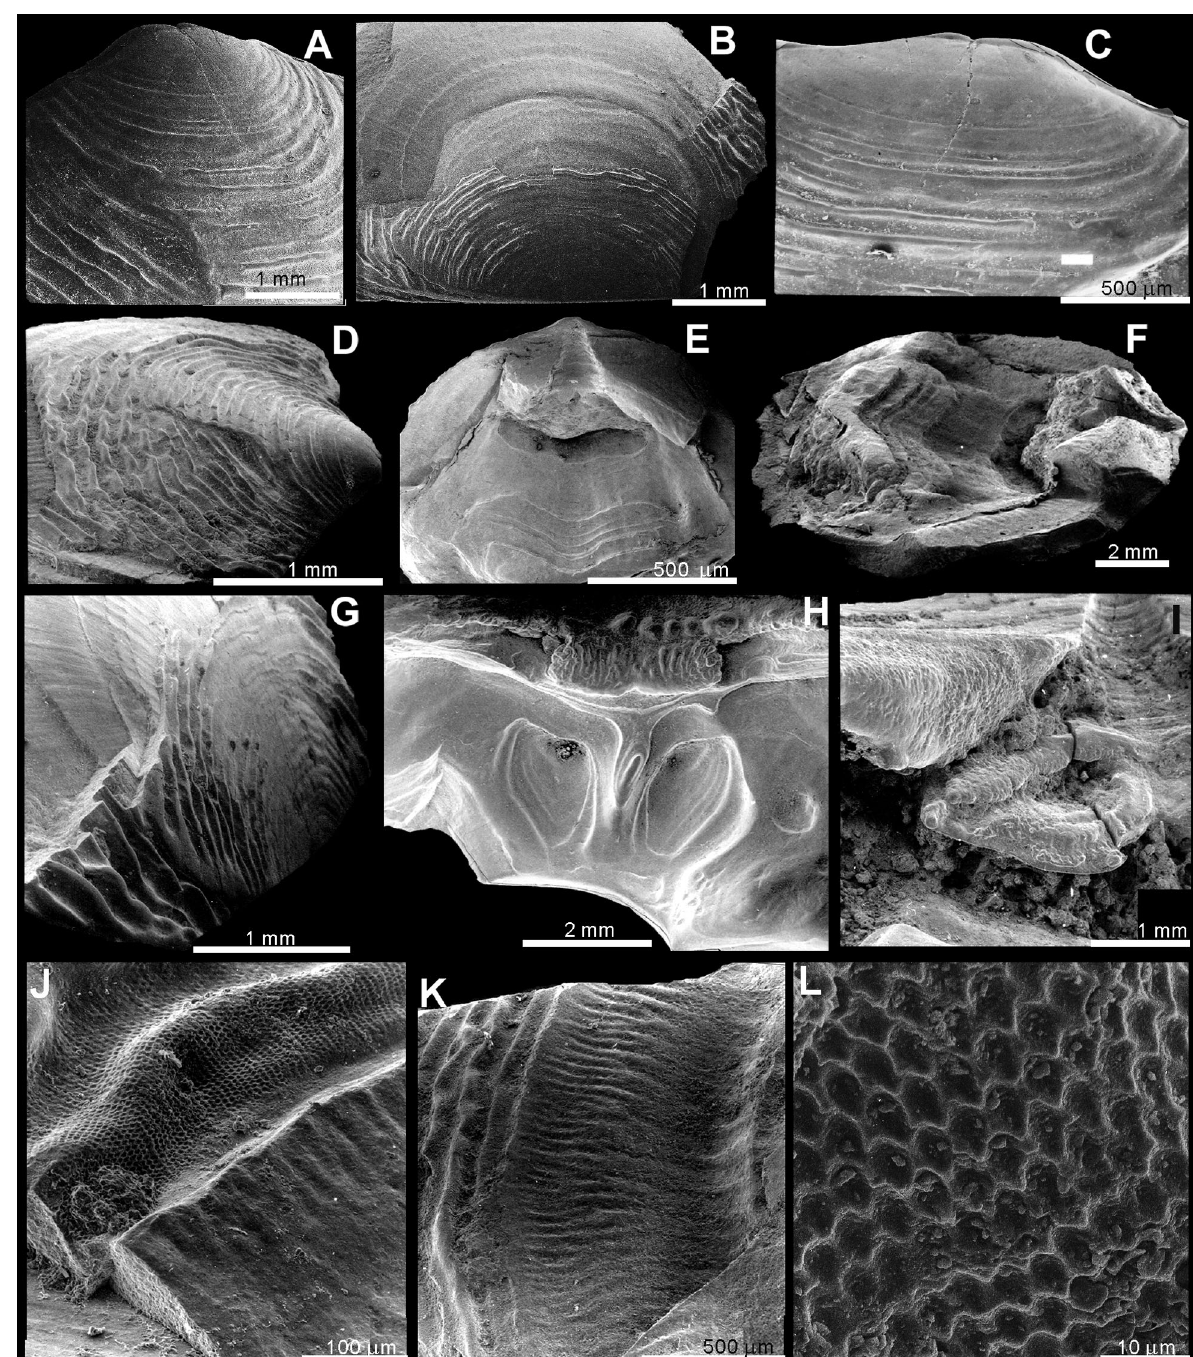
Fig. 3. Aulonotreta antiquissima (Eichwald, 1843), from the Dapingian Volkhov Regional Stage. A , NRM-PZ Br65710, fragmented ventral exterior, Tallinn, Estonia, detail of umbo. B , NRM-PZ Br65709, fragmented dorsal exterior, Tallinn, Estonia, posterior view. C , detail of larval shell of A. D , lateral view of umbo of A. E, F , NRM-PZ Br65717, fragmented ventral interior, Tallinn, Estonia: E, ventral view; F, lateral view. G , lateral view of umbo of B. H , NRM-PZ Br133718, fragmented dorsal interior, Tallinn, Estonia. I , NRM-PZ Br133529, detail of umbonal process of ventral interior, Tallinn, Estonia. J – L , detail of partly exfoliated exterior of A: J, showing post-larval rugae with micro-pits; K, detail of vascula terminalia ; L, detail of rhomboidal